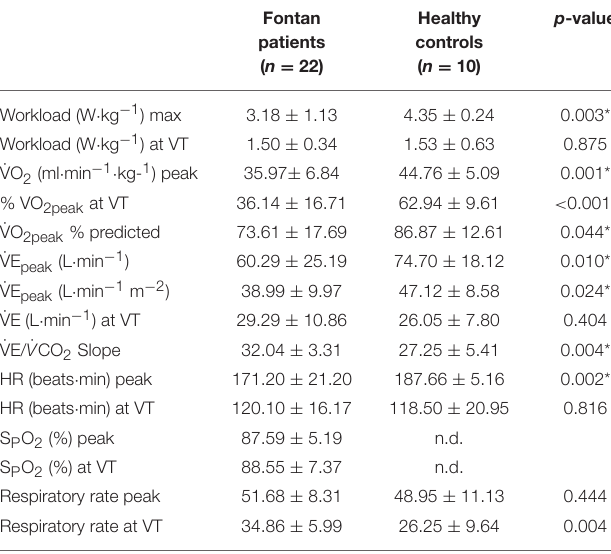
TABLE 2 | Parameters of CPET in fontan patients and healthy controls measured at the ventilatory threshold and at peak level. Fontan patients